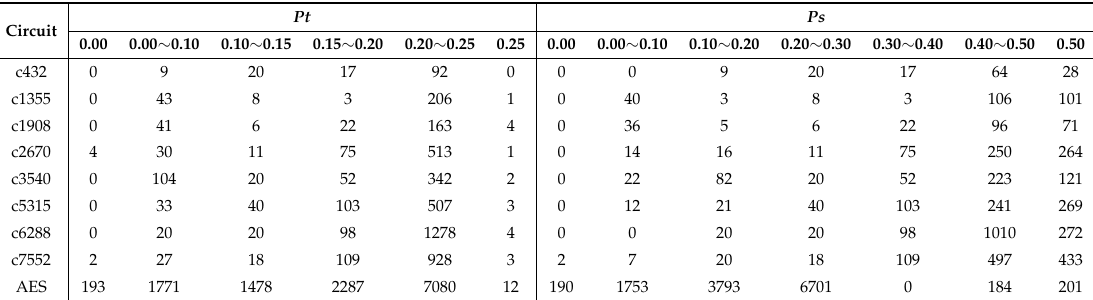
Table 1. Table of the number of nodes based on Pt and Ps